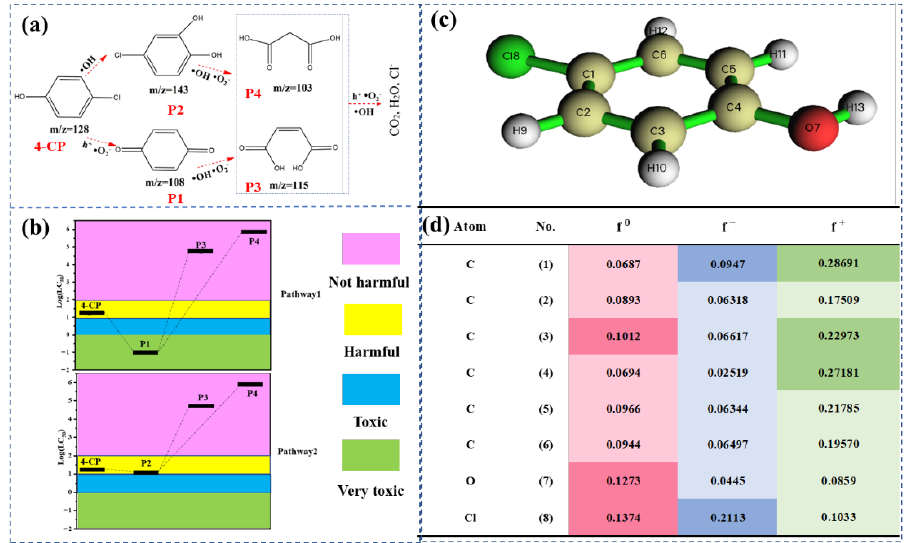
Figure 4. ( a ) Photocatalytic degradation pathways of 4-CP; ( b ) acute toxicity LC 50 of 4-CP and its possible intermediates; ( c ) molecular structural formula of 4-CP; and ( d ) calculated Fukui index of 4-CP.